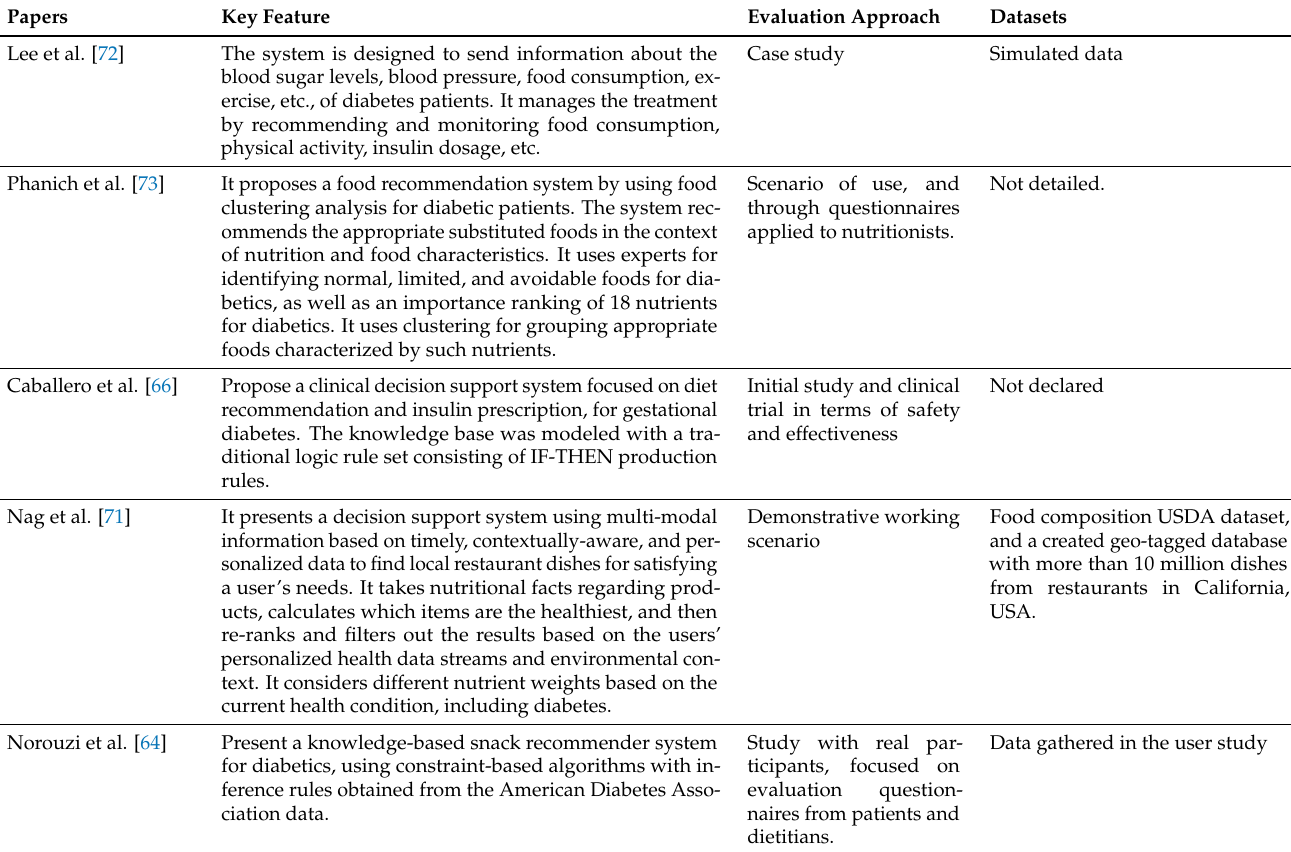
Table 3. Summary of the identified related works using rule-based and classification